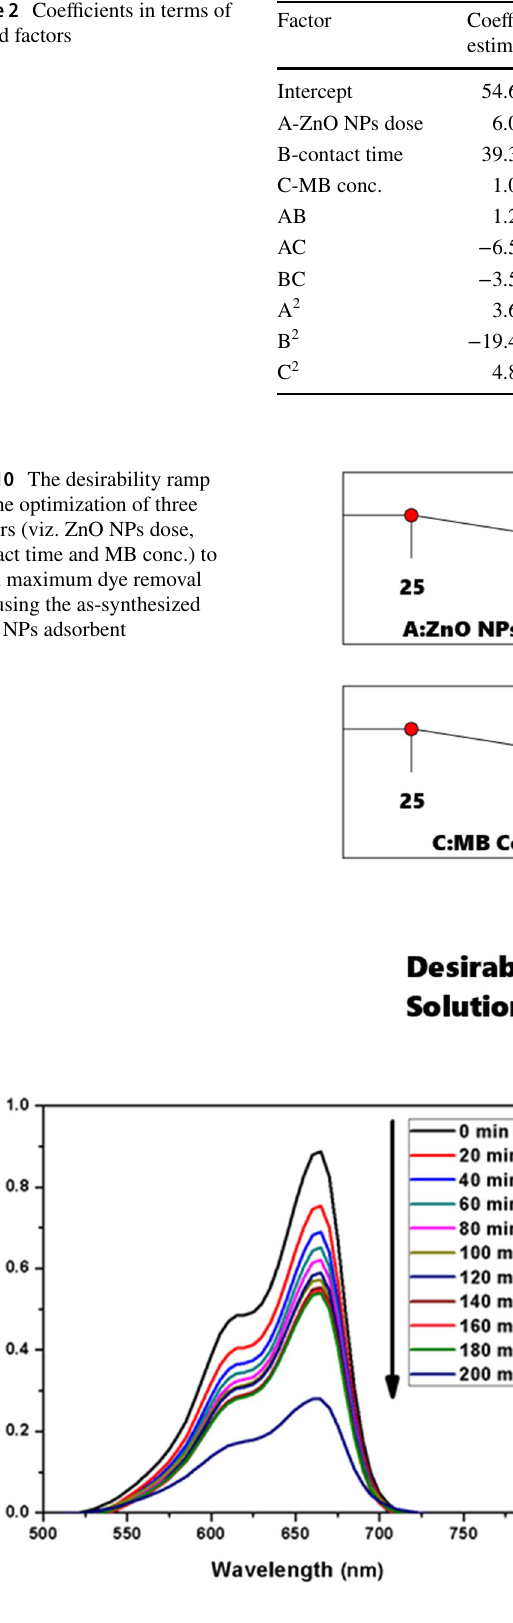
Fig. 11 a Photocatalytic degradation of MB using ZnO NPs catalyst and b pseudo first order